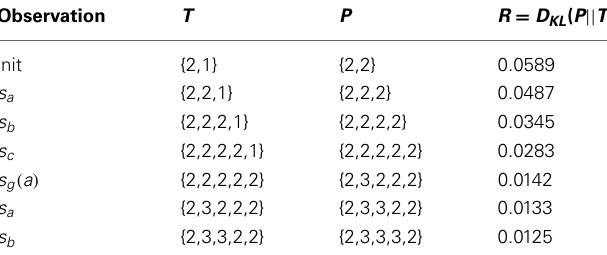
Table 4 | An unpredictable